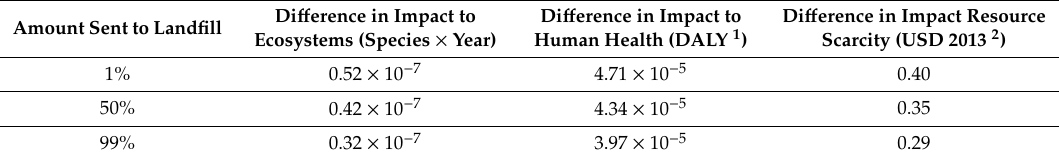
Table 1. Impact of end of life scenario on the endpoint scores of 1 m 3 a pyrolytic sugar treated wooden